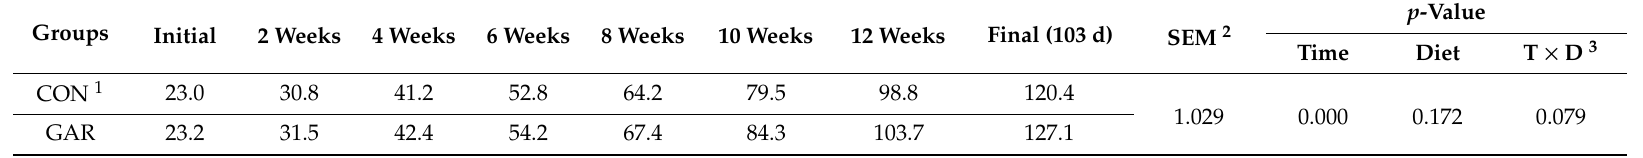
Table 3. The e ff ect of dietary inclusion of Allium spp. extract on body weight of growing-finishing pigs. Groups Initial 2 Weeks 4 Weeks 6 Weeks 8